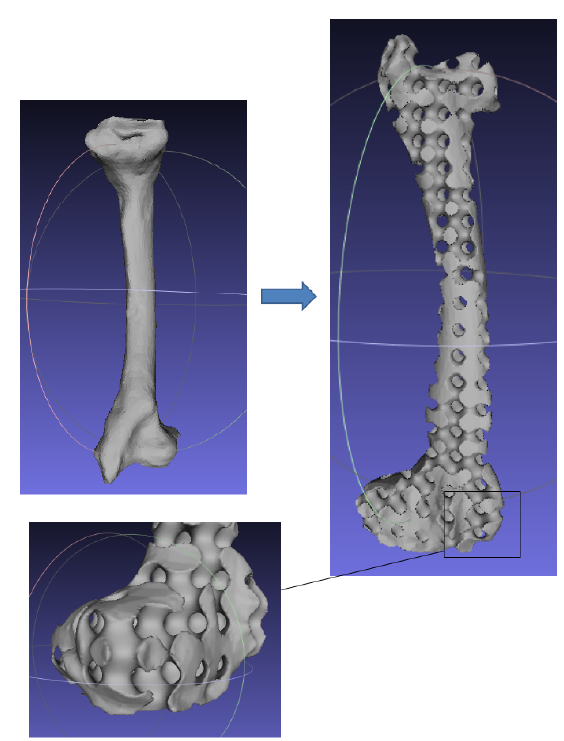
Figure 1. Porous fumer bone scaffold generated by TPMS. Deformed structures are obvious on the surface